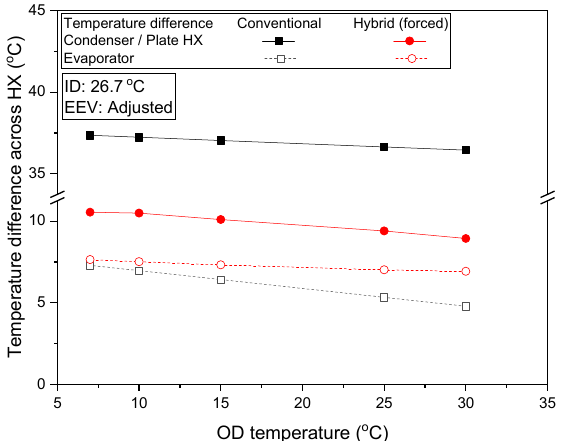
Figure 9. HX temperature comparison for novel hybrid IDC cooling and conventional IDC cooling system.